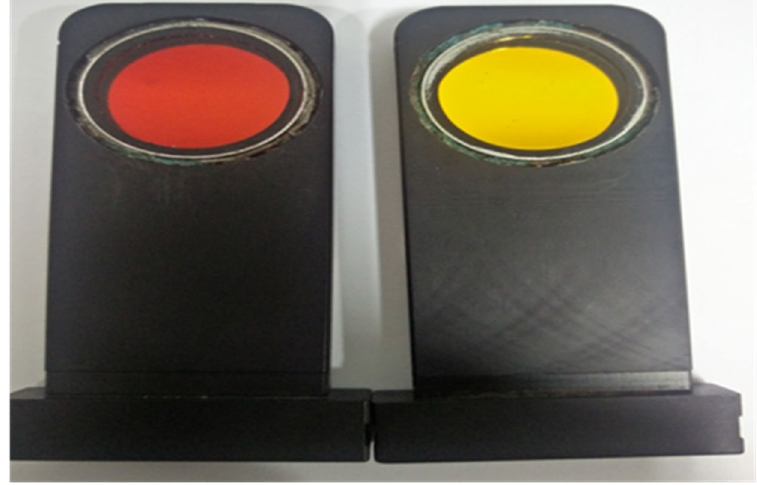
Figure 1. Manual Filters of wavelength 570 and 600 nm used for capturing the retinal